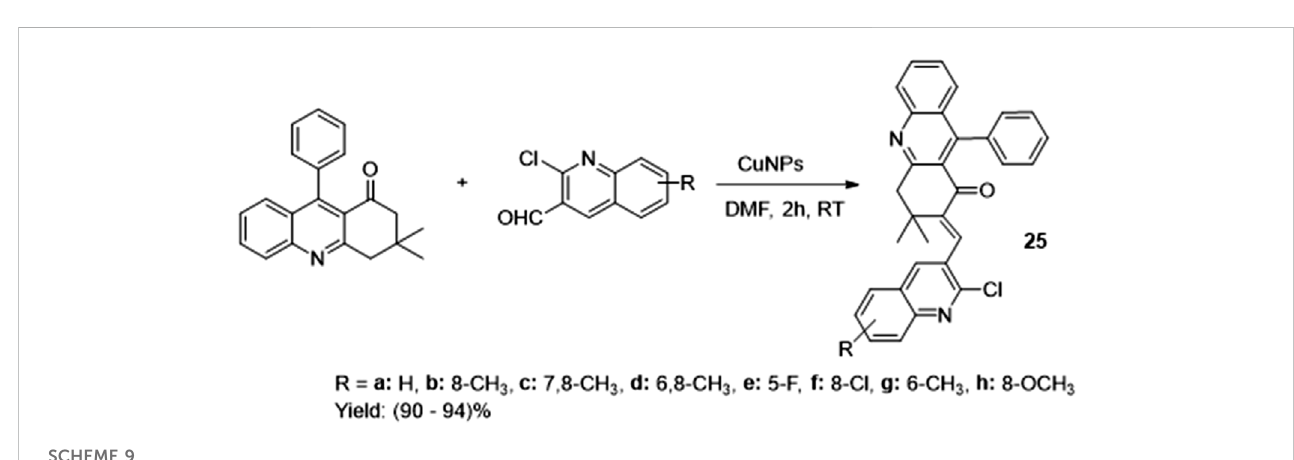
SCHEME 9 CuNPs mediated Knoevenagel